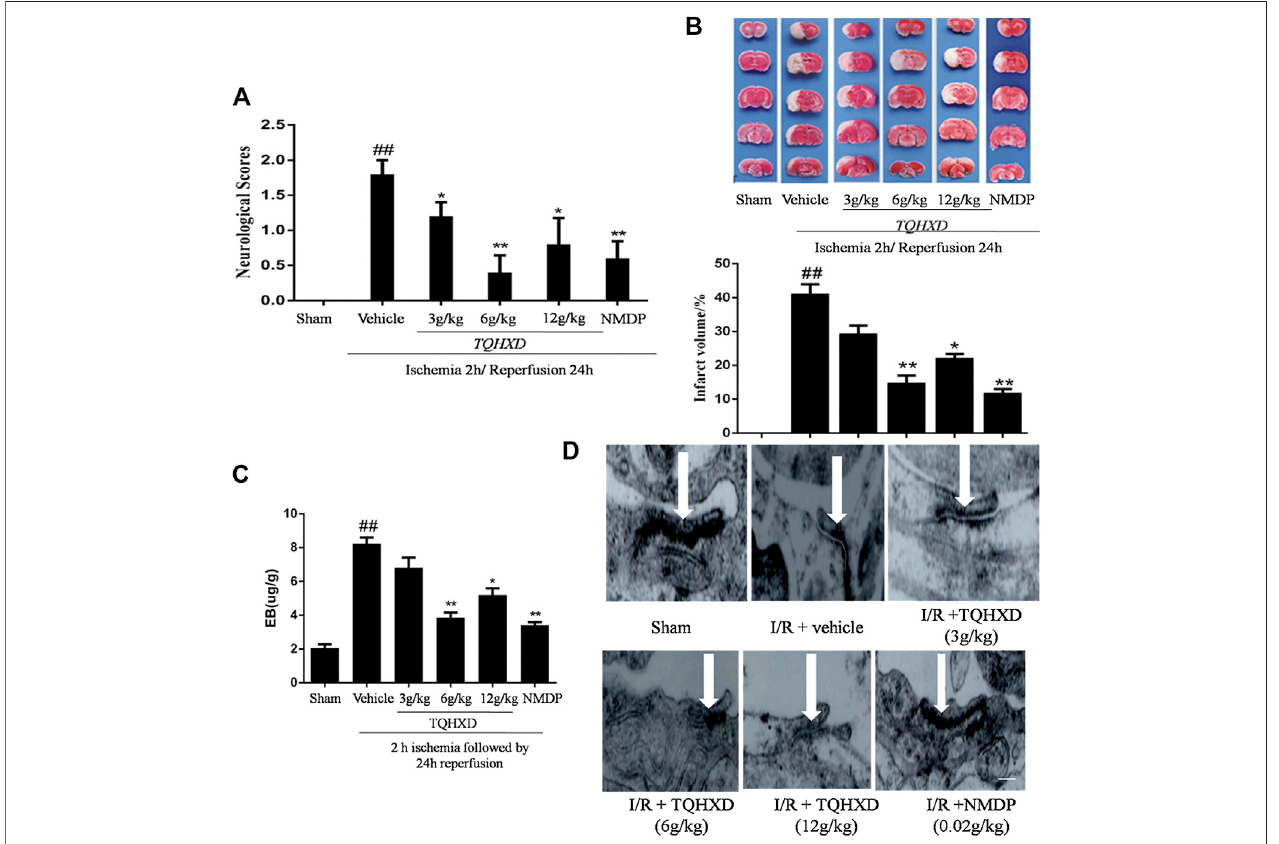
FIGURE 5 | TQHXD ameliorated I/R injury and attenuated blood-brain barrier damage. (A) The neurological scores were evaluated by Longa ’ s methods. (B) Representative TTC staining (top) and quantitative analysis (bottom) of brain infarct volumes, n (cid:1) 6. (C) Quantitative analysis of the content of EB, n (cid:1) 6. (D) Representative TEM images of ultrastructural changes in I/R-induced tight junction ( n (cid:1) 3). Arrows imply electronically dense bands; the electronically dense bands represent TJ; the open state of electronically dense bands represents the injury degrees of TJ; scale bar (cid:1) 200 μ m ( × 20,000 magni fi cation). Data are presented as means ± SD. ## p < 0.01 vs. sham group; * p < 0.05, ** p < 0.01 vs. vehicle